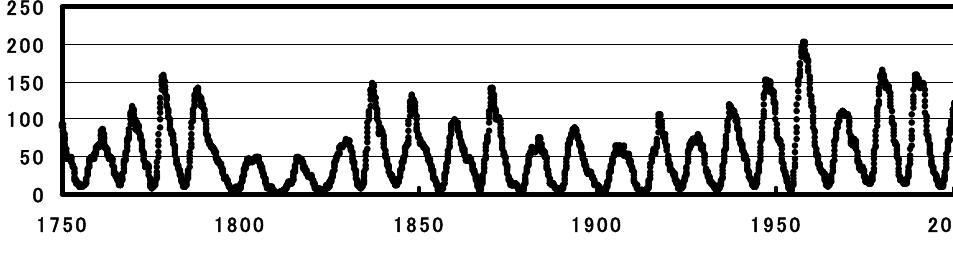
Fig. 2. Monthly smoothed sunspot number since 1750.